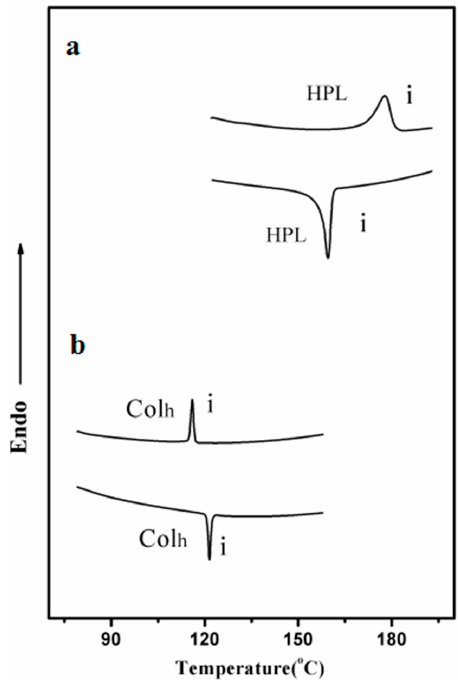
Figure 1. DSC traces (10 °C·min − 1 ) recorded during the heating and cooling scans of ( a ) 1 and ( b ) 2 (HPL: hexagonal perforated lamella; i: isotropic phase; Col h : hexagonal columnar).